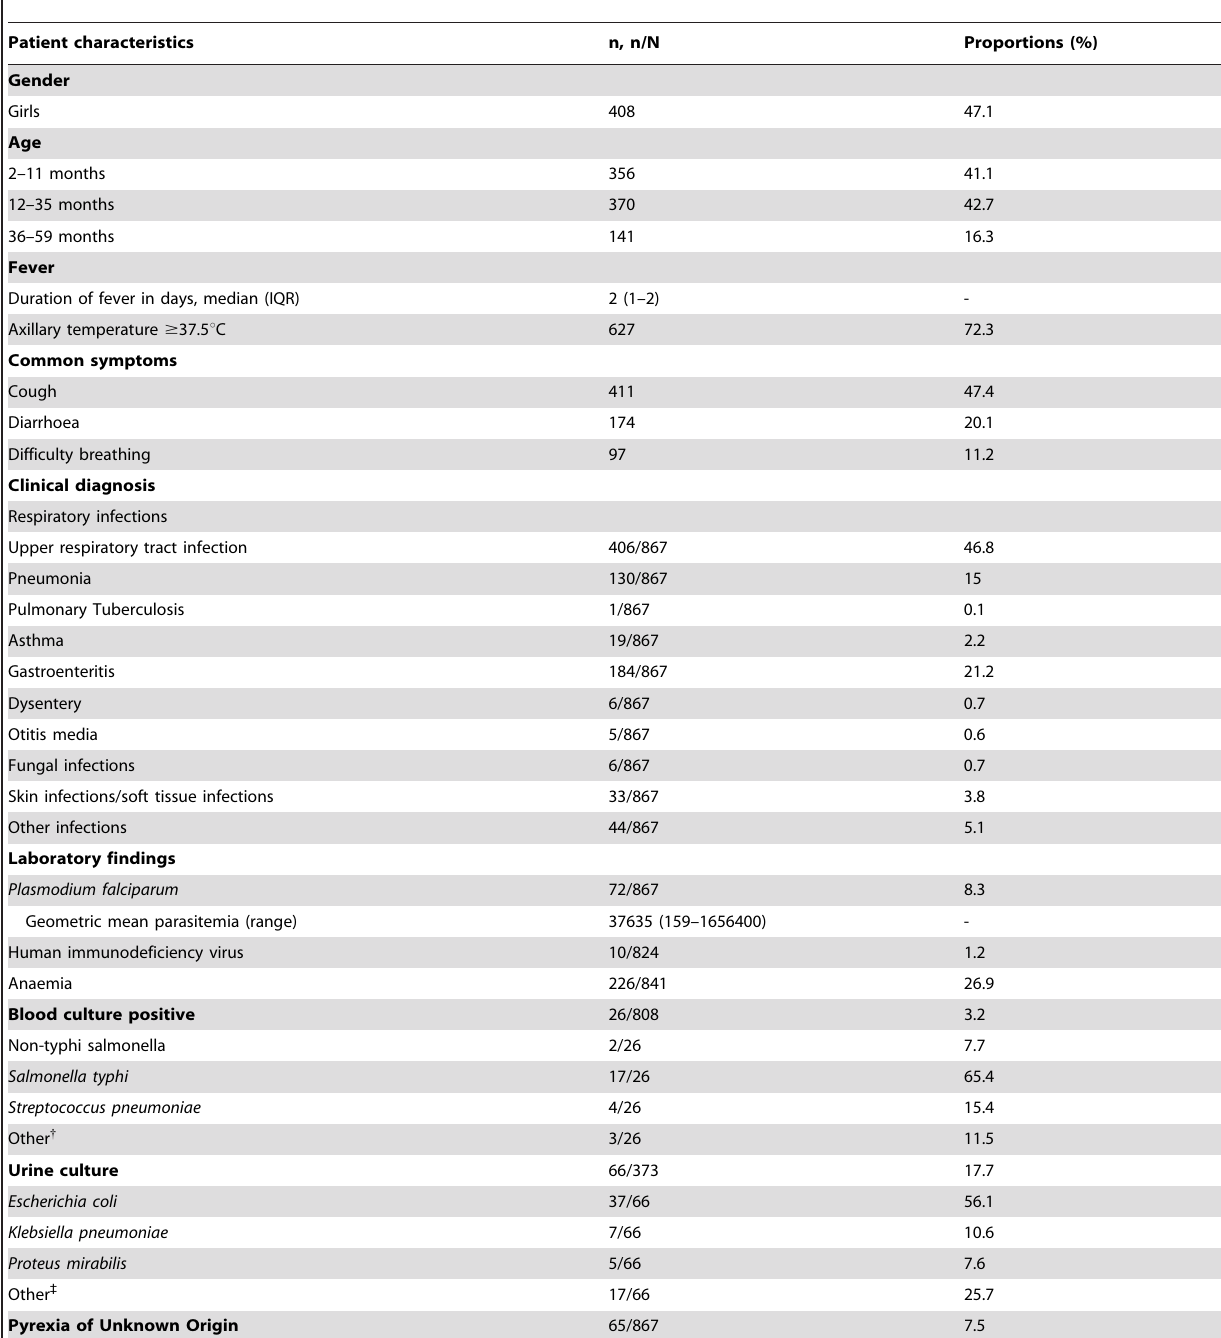
Table 1. Demographic characteristics, clinical diagnosis and laboratory findings of patients enrolled at KDH.